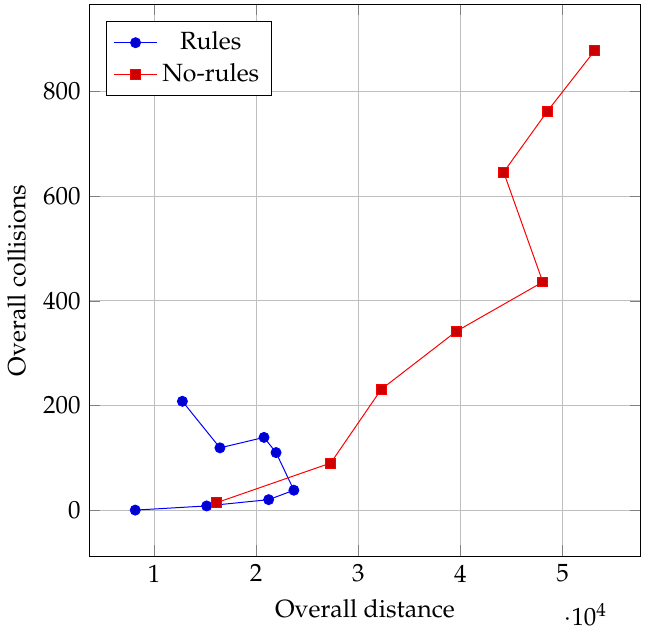
Figure 6. Overall number of collisions in the simulation against the overall traveled distance in the simulation, averaged across simulations with the same n car . Each dot is drawn from the sum of the values computed on the n car